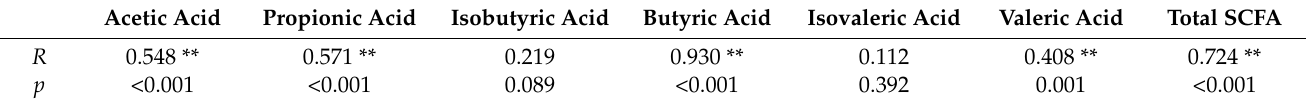
Table 6. Correlations between dietary fiber intake and short chain fatty acids in feces. Acetic